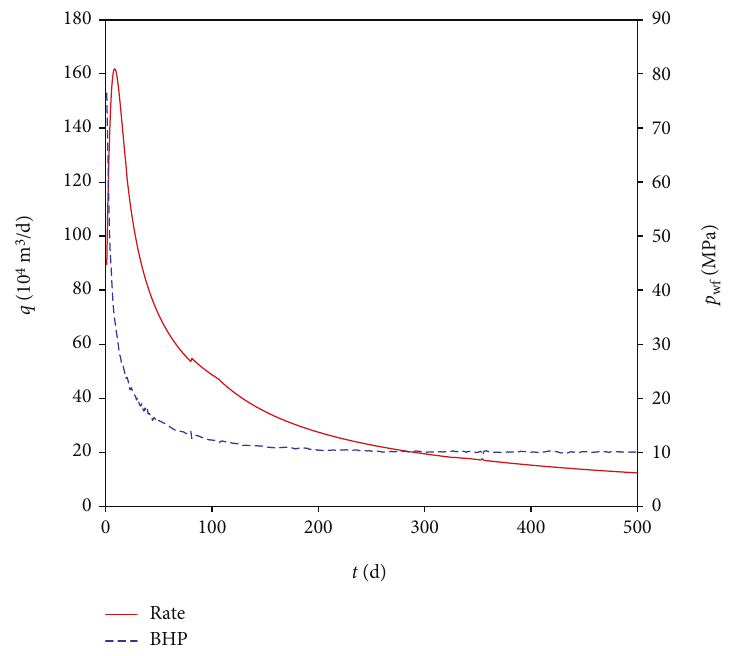
) and g ð p Þ vs. pressure ( p ) for the fi eld case. p